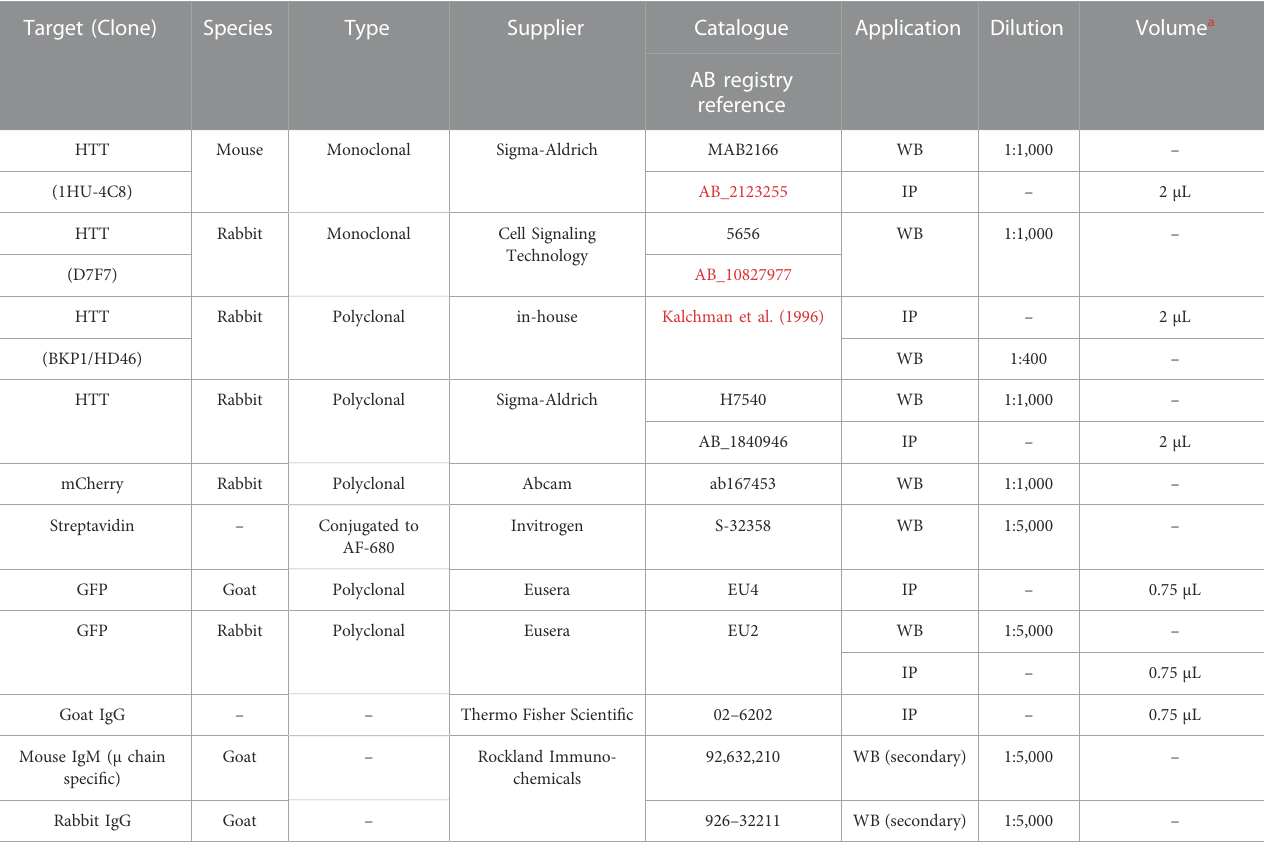
TABLE 2 List of antibodies used and application. Target